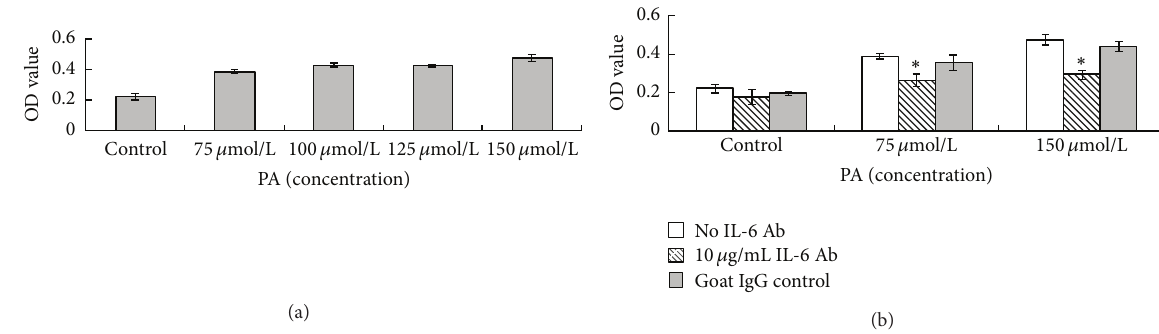
Figure 8: Induction of cell proliferation by palmitic acid is dependent of IL-6. (a) Cells were untreated or treated with PA (75, 100, 125, and 150 𝜇 mol/L) for 24 hours. Cell viability was measured by a CCK-8 assay kit. Data are expressed as mean ± standard deviation ( 𝑛 = 5 ). ∗ 𝑃 < 0.05 compared with control. (b) Cells were untreated or treated with PA (75 and 150 𝜇 mol/L) for 24 hours, with or without the presence of 10 𝜇 g/mL goat anti-human IL-6 polyclonal neutralizing antibody (IL-6 Ab) or control goat IgG in cell culture system. Cell viability was measured by a CCK-8 assay kit. Data are expressed as mean ± standard deviation ( 𝑛 = 5 ). ∗ 𝑃 < 0.05 compared with treatments without IL-6